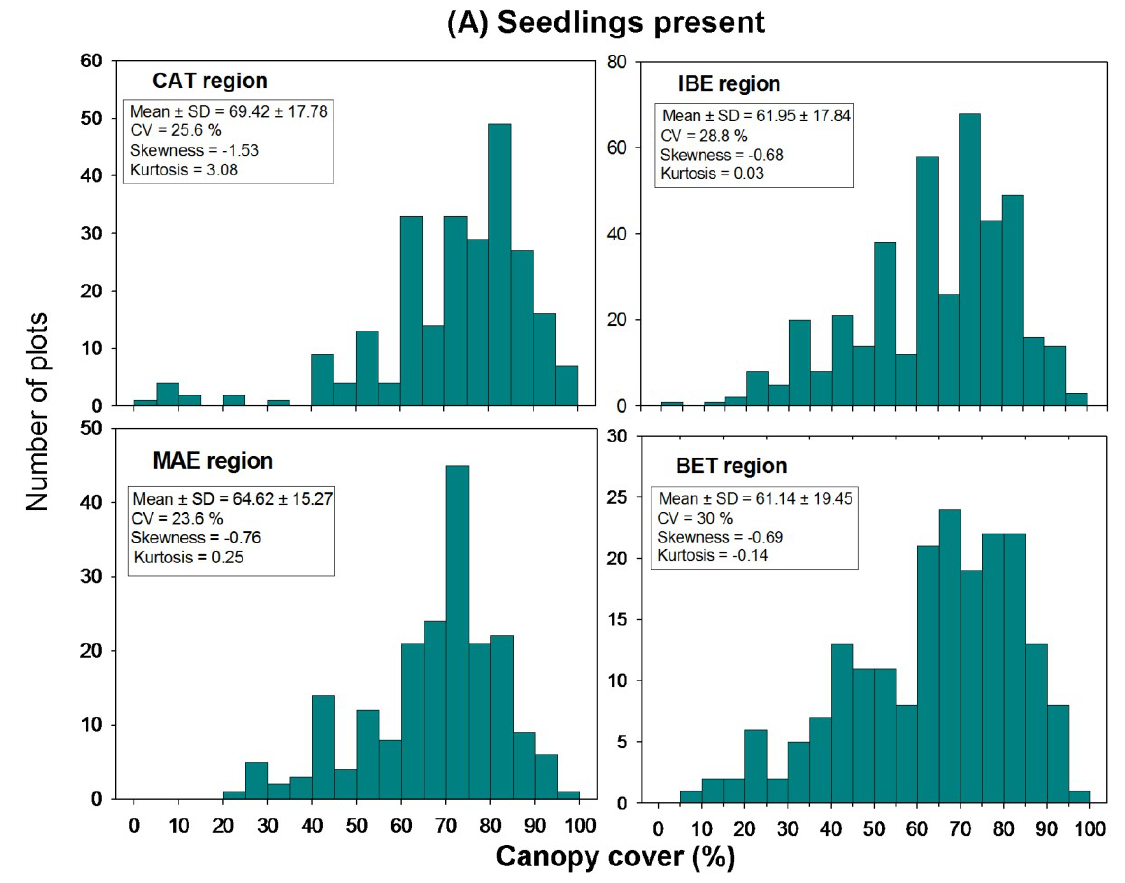
Figure 5. Frequency distribution and descriptive statistics of canopy cover in sites where seedlings were present ( A ) or absent ( B ) within each study region. SD is the standard deviation; CV is the coefficient of